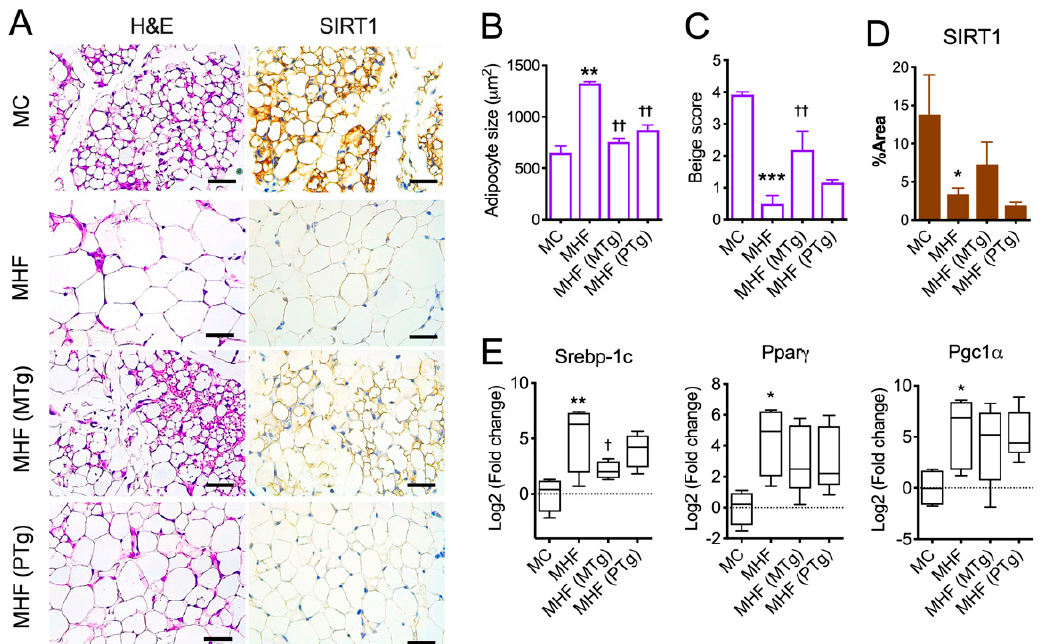
Figure 2. Parental SIRT1 overexpression attenuates adipocyte hypertrophy and lipid dysregulation